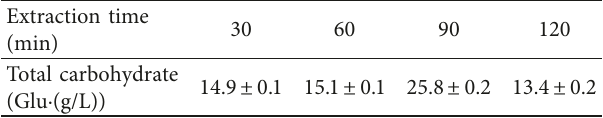
Table 2: Optimized extraction time for sugar extraction from semiliquid samples.